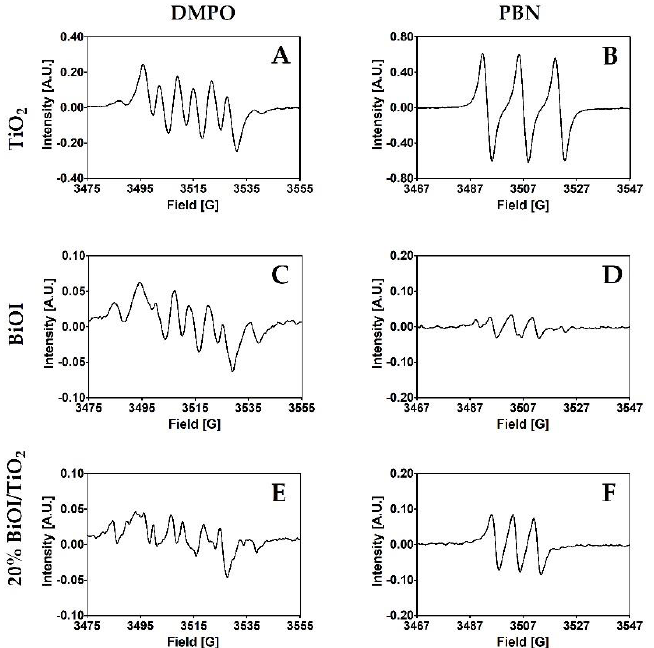
Figure 9. In situ EPR signal observed in oxofunctionalization of cyclohexane saturated with air under visible light irradiation by a 400 W metallic halide lamp driven by. ( A ) TiO 2 in presence of DMPO; ( B ) TiO 2 in presence of PBN; ( C ) BiOI in presence of DMPO; ( D ) BiOI in presence of PBN; ( E ) 20% BiOI/TiO 2 in presence of DMPO and ( F ) 20% BiOI/TiO 2 in presence of PBN.